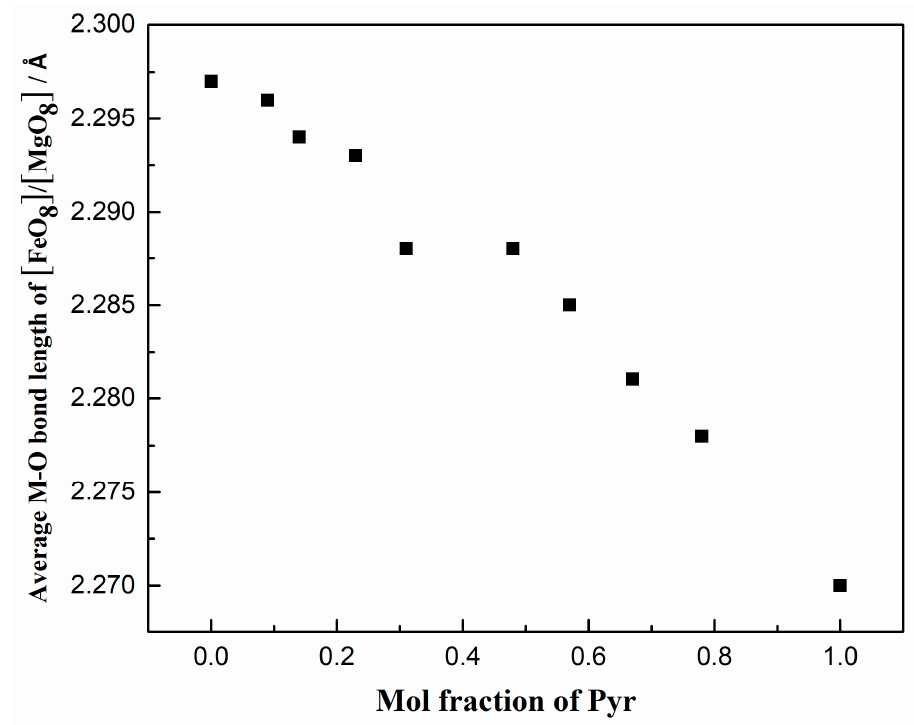
Figure 5. Average M-O bond length of [MgO 8 ] / [FeO 8 ] dodecahedron versus the pyrope mol.%. M represents the Mg 2+ or Fe 2+ .